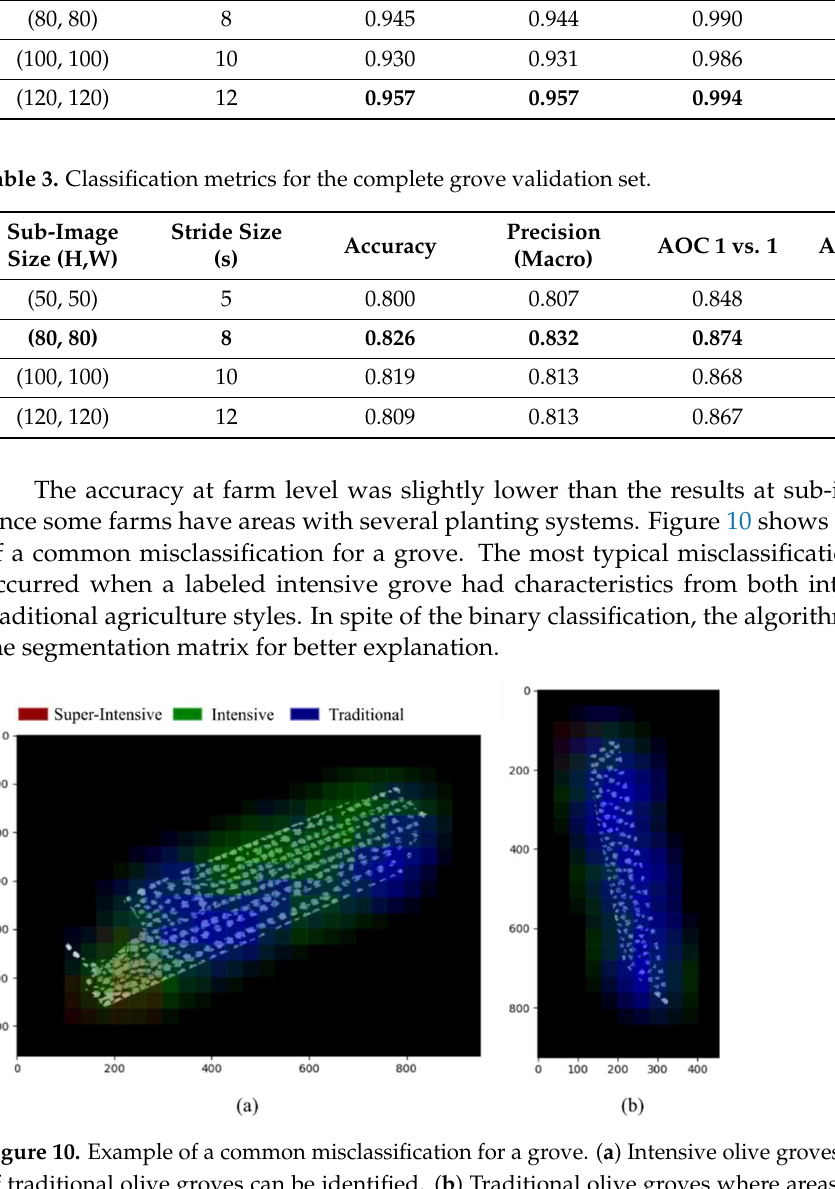
Table 3. Classification metrics for the complete grove validation set.